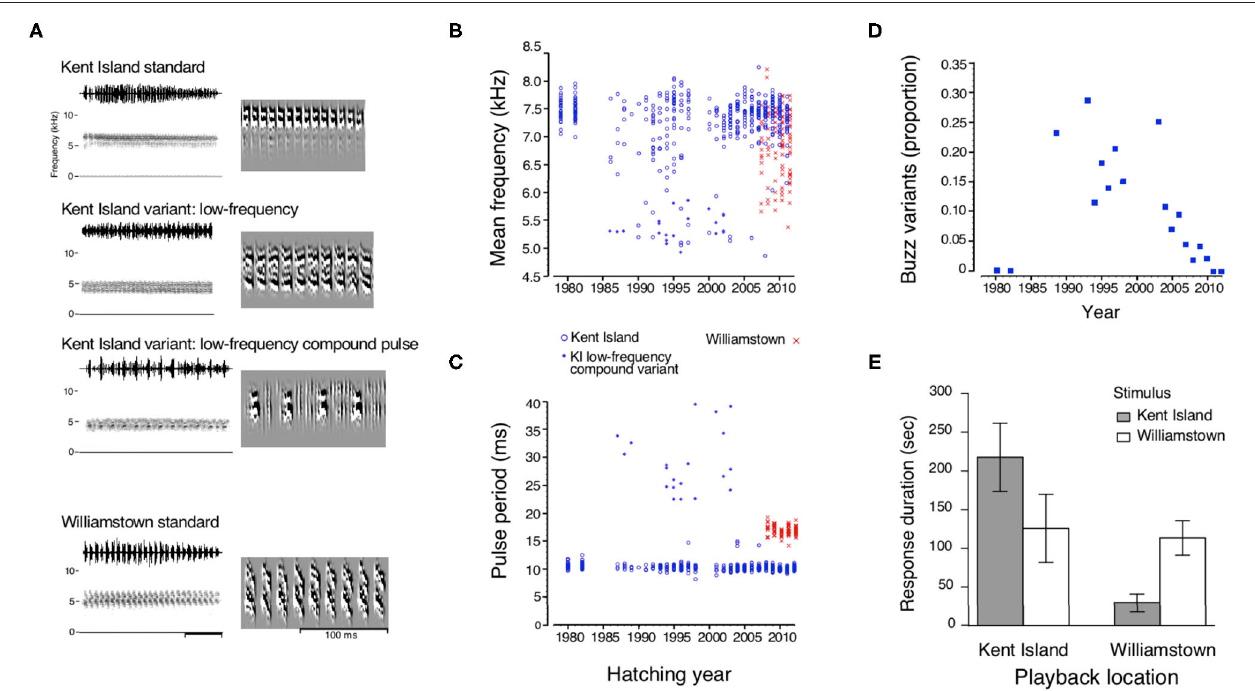
FIGURE 2 | The population-specific buzz segment: maintenance of stability. (A) Sonograms of three forms of buzz sung by the Kent Island population and the single form sung by a 600km distant population in Williamstown. Two low-frequency variants (differing in the duration and form of the constituent pulses) were sung by a total of 8.4% of the birds recorded on Kent Island between 1980 and 2012. (B) Distribution of mean frequencies and (C) pulse durations of buzzes sung by Kent Island and Williamstown birds. (D) The proportion of birds singing variant buzzes on Kent Island during years when recordings were made. (E) Males respond more aggressively, as measured by response duration, to the standard local buzz than to foreign buzzes (error bars represent 2 SEM) (After Williams et al.,